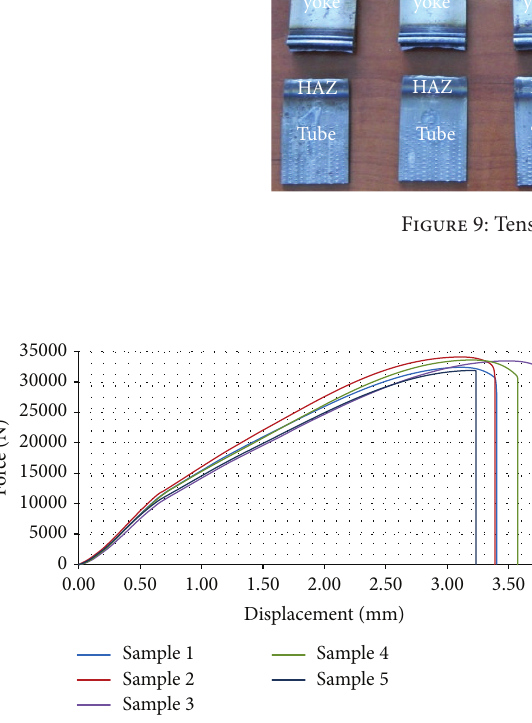
Figure 10: Tensile test results of welded joints.